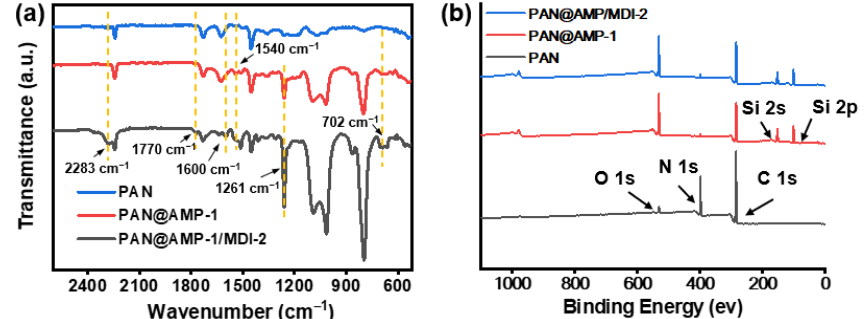
Figure 6. ( a ) FT-IR spectra and ( b ) XPS survey spectra of PAN original membranes, PAN@AMP-1 and PAN@AMP-1/MDI-2 nanofibrous